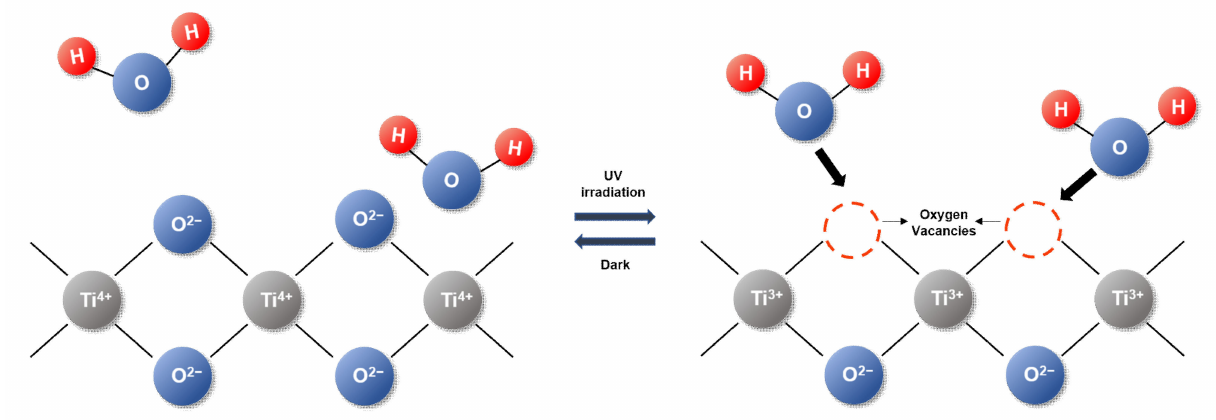
Figure 5. Atomic arrangement with the generation of surface oxygen